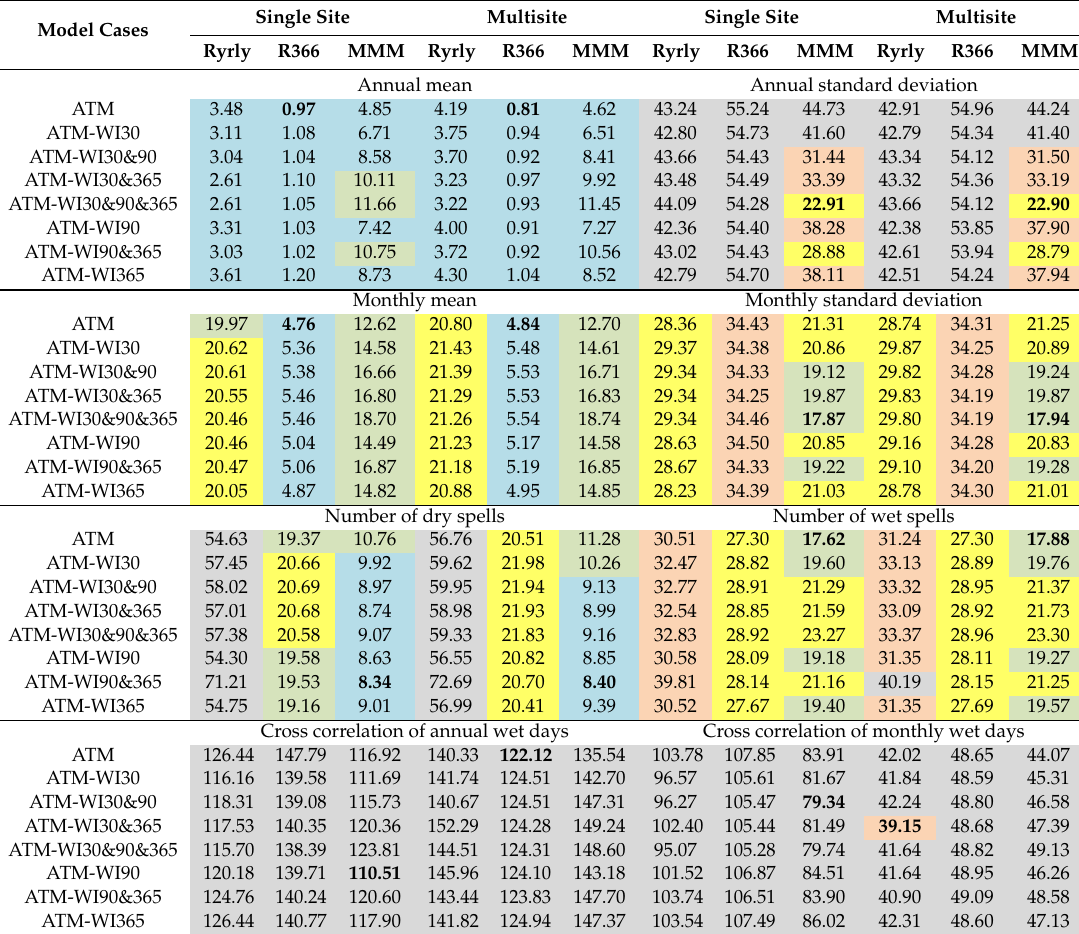
Table 2. Relative root mean square error (Rel. RMSE) of basic statistics for validation time period. Model